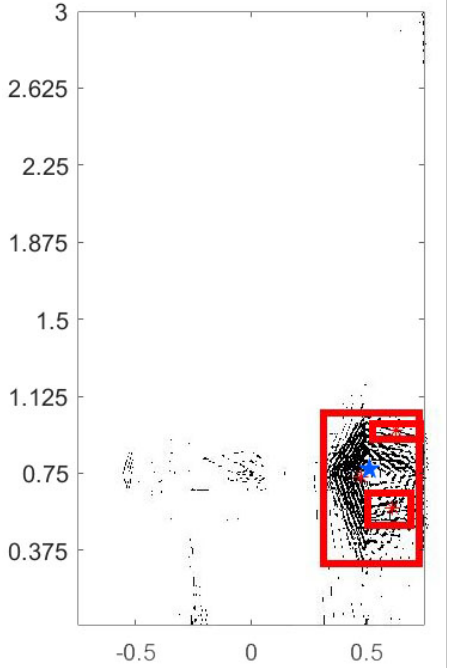
Figure 15 . Determination of the suspected leakage area and leakage position. Figure 15. Determination of the suspected leakage area and leakage